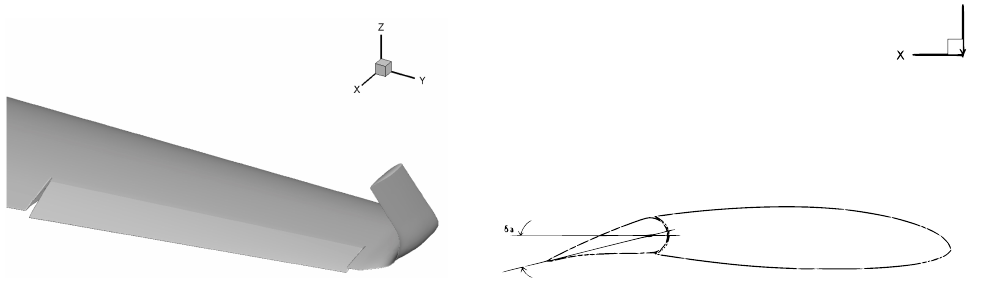
Figure 6. Close-up view of the CAD model for the right aileron ( left ), with illustration of the deflection angle ( right ).